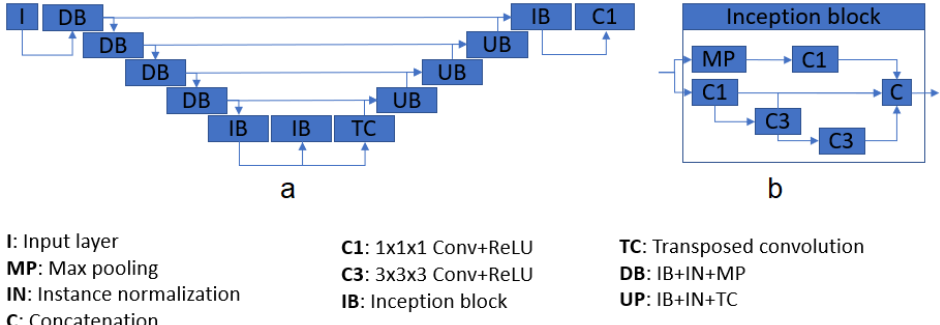
Figure 2. Architecture diagram ( a ), and inception module pipeline ( b ).